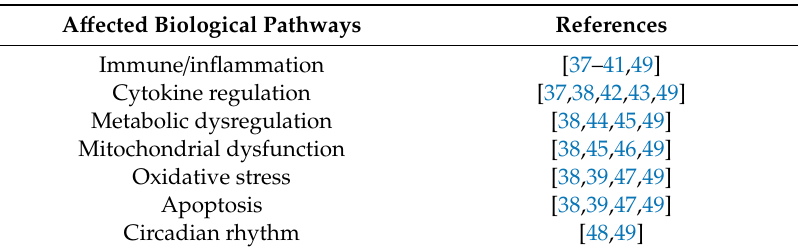
Table 1. Biological Pathways affected in ME/CFS. A ff ected Biological Pathways